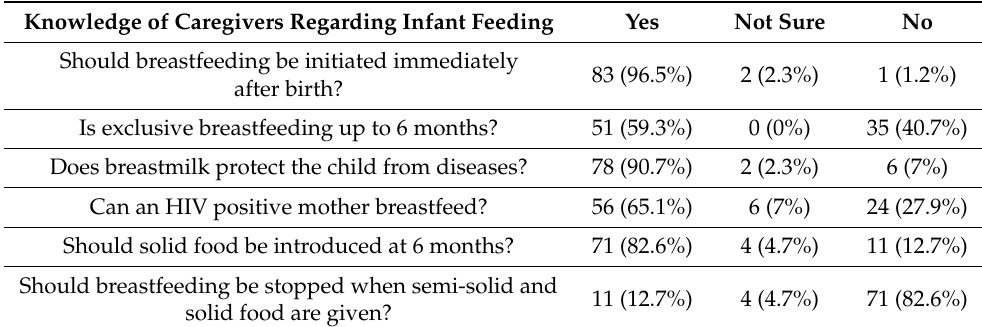
Table 2. Knowledge of participants regarding infant feeding, % in rows ( n = 86).